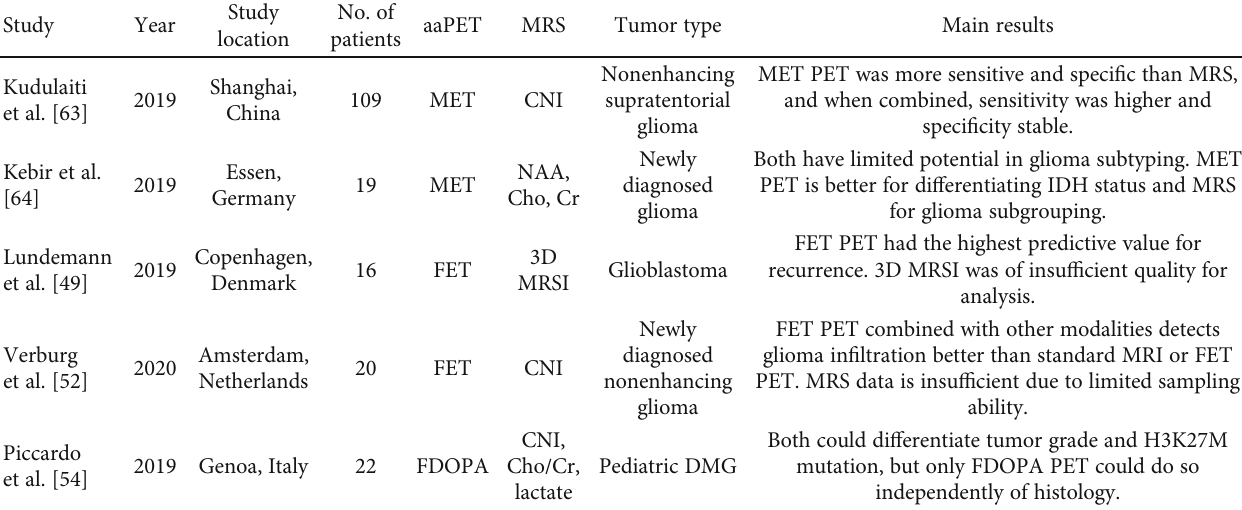
Table 3: Summary of aaPET with MRS